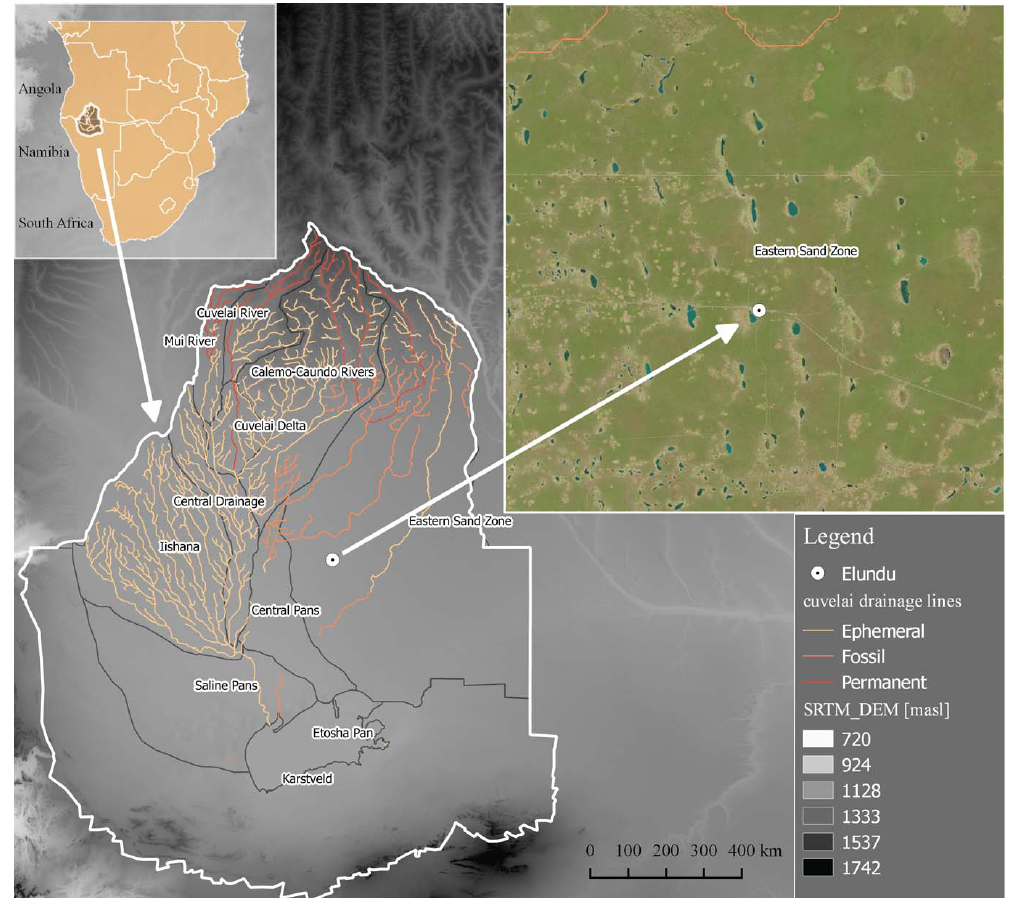
Figure 1. The study area is located in the northern part of the Cuvelai–Etosha Basin (CEB), which is subdivided by the political border between Angola and Namibia (left). Sampling was conducted in Elundu, located in the center of the CEB (center,